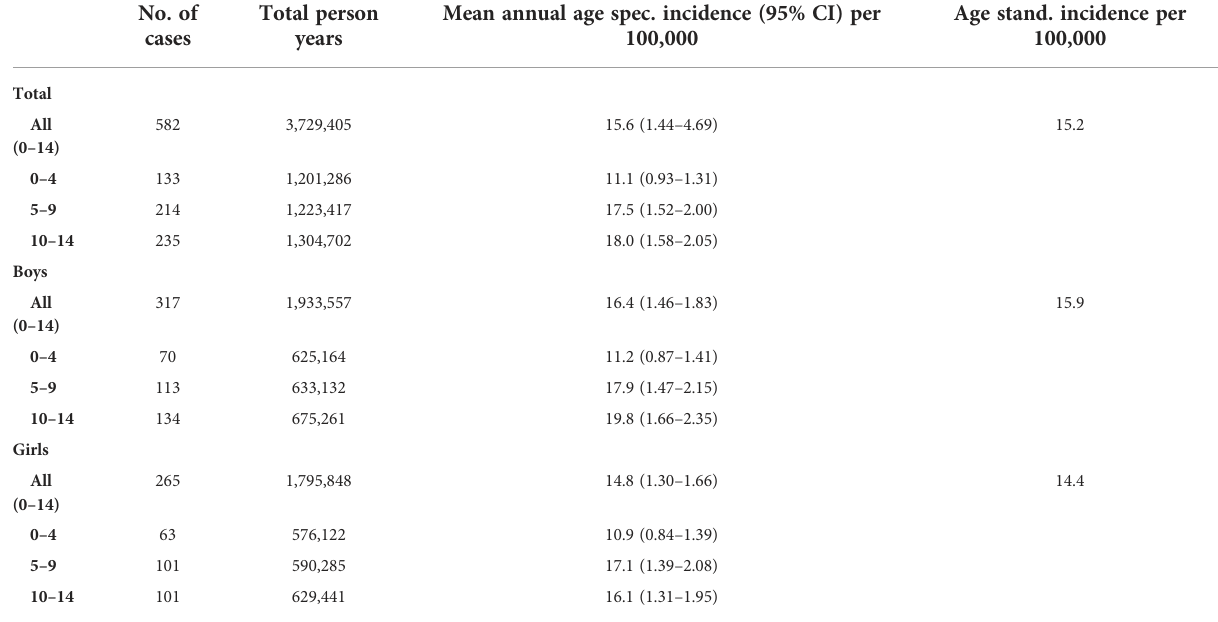
TABLE 1 Number of cases, total person years, means annual incidence, age-speci fi c incidence, and age-standardized incidence of T1D in Montenegro during the period 1991 – 2020. No.